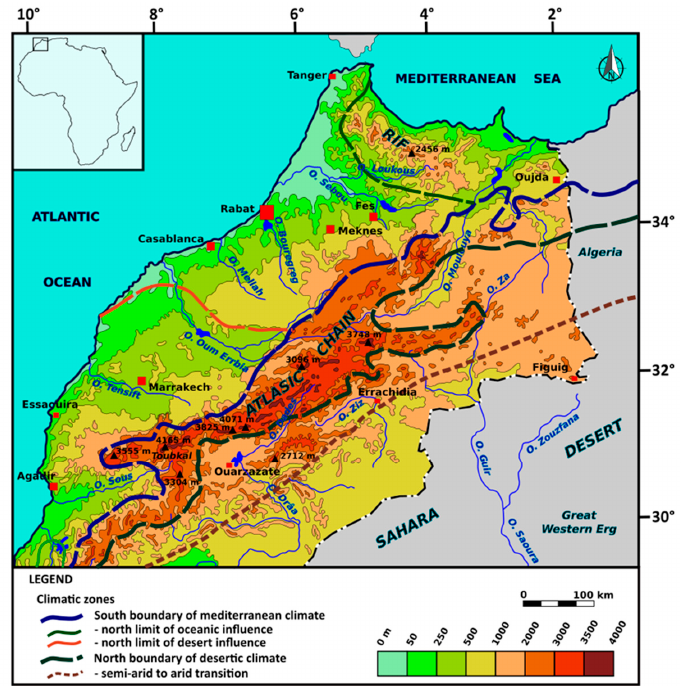
Figure 1. Climatic zone boundaries of Northern Morocco on both sides of Atlas ranges under mountainous climate influence (modified from [12–15]). Located in Northeast Morocco, along the Algerian border, the hydrographic basin of the Upper Guir includes, respectively, the occidental and oriental parts of the administrative regions of Errachidia and Figuig (Figure 1). This area stretches from the southeastern foothills of the Atlas ranges to the western end of the Sahara Desert. The highlands of the High Atlas receive the most important part of the rainfall and represent the regional recharge zone. From an economic standpoint,